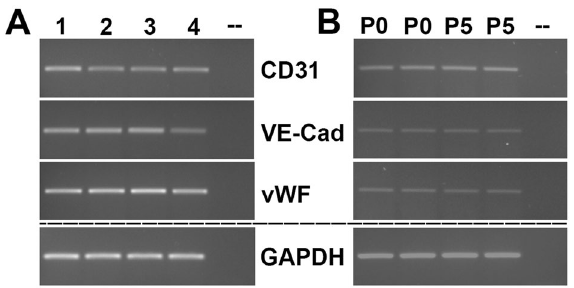
Figure 4. mRNA-Expression of the endothelial cell specific markers CD31, VE-Cadherin and von Willebrand factor was confirmed via RT-PCR in four independent EC isolations at passage 1 (1–4) ( A ). No differences were found in the expression patterns of CD31, VE-Cadherin, vWF and GAPDH between ECs gained directly after isolation (P0) and at passage 5 ( B ). Equal amounts of cDNA were used as verified by the GAPDH positive control. Omission of the template cDNA (–) revealed no signal. The PCR products of CD31, VE-Cadherin and von Willebrand factor were separated on the same gel, while GAPDH was separated independently. Uncropped gels can be found in Supplementary Fig. S1 in the Supplementary information